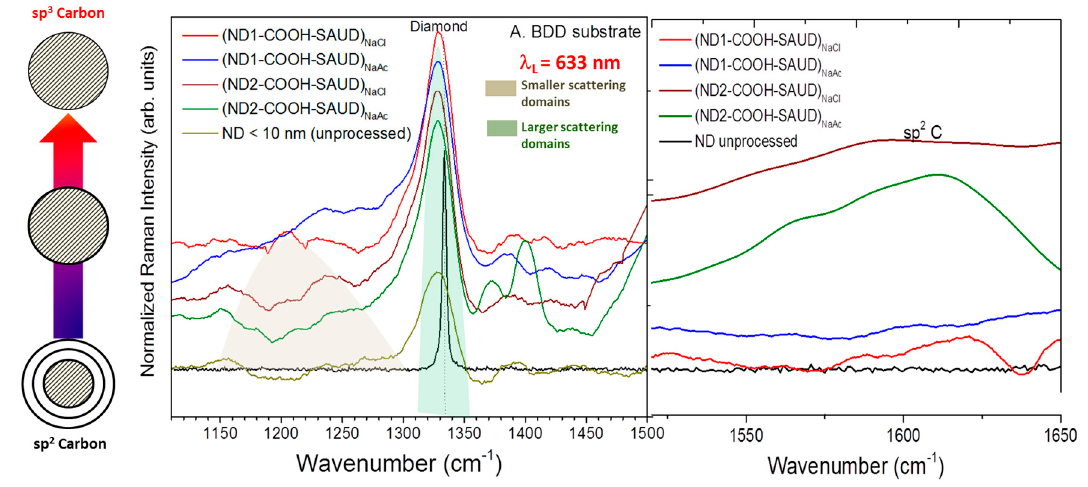
Figure 4. Normalized Raman spectra of nanodiamond series (ND1-COOH and ND2-COOH) displaying characteristic diamond Raman peaks along with micro-diamond peak and the non-diamond region.